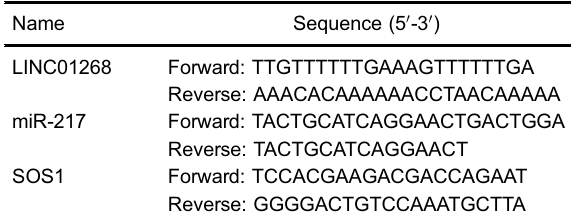
Table 2. Primers for quantitative real-time